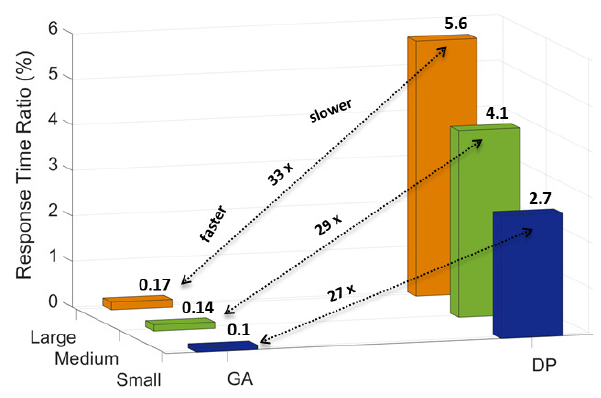
Figure 8. Response time ratio to the corresponding endurance with respect to different approaches under different scenarios In Figure 8, a percentage value with